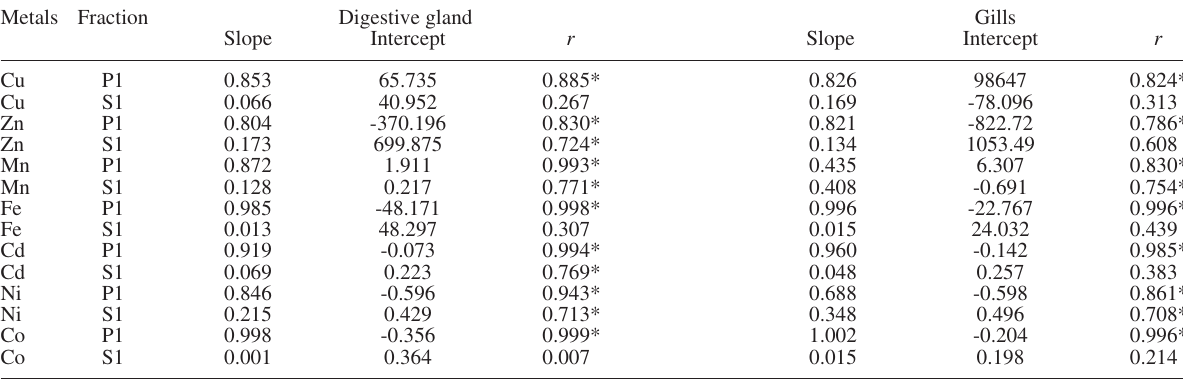
Table 2. – Soluble (S1) and insoluble (P1) fractions vs. total metal contents in digestive gland and gill of C. angulata : slope, intercept and correlation coefficients of regression straight lines. (n=36, for Zn